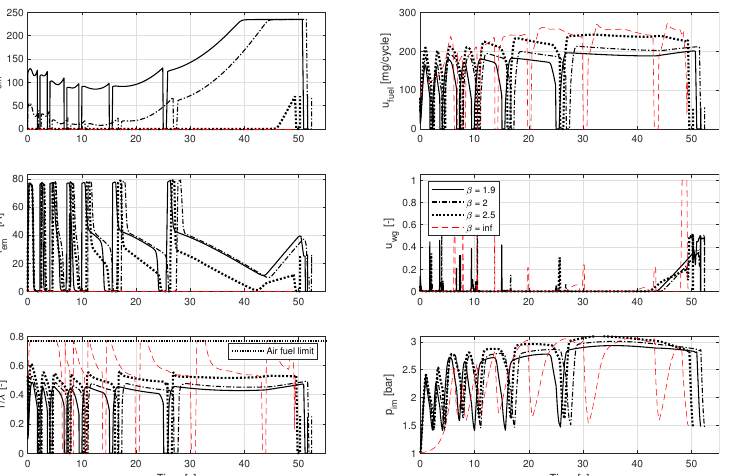
Figure 13. Controls, fuel-air ratio and intake manifold pressure during the acceleration from 8 to 80 km/h when both E-crank and E-turbo are used.